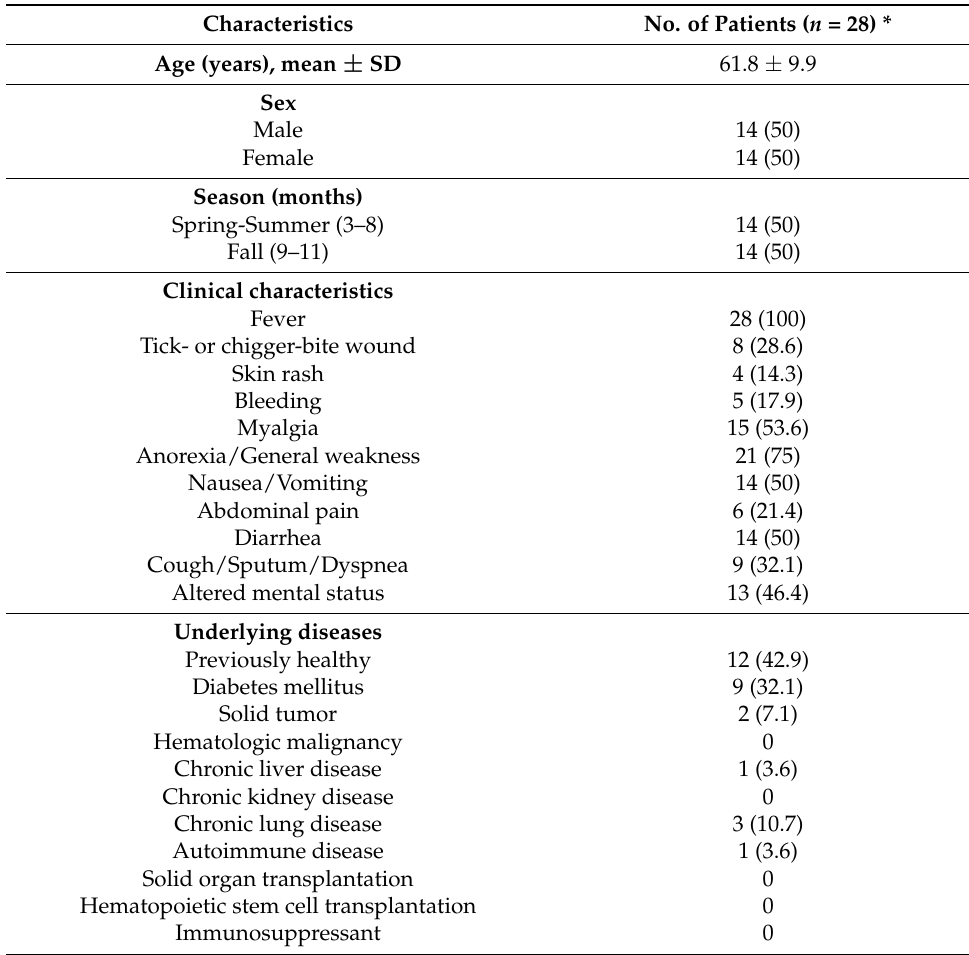
Table 1. Clinical characteristics of the studied